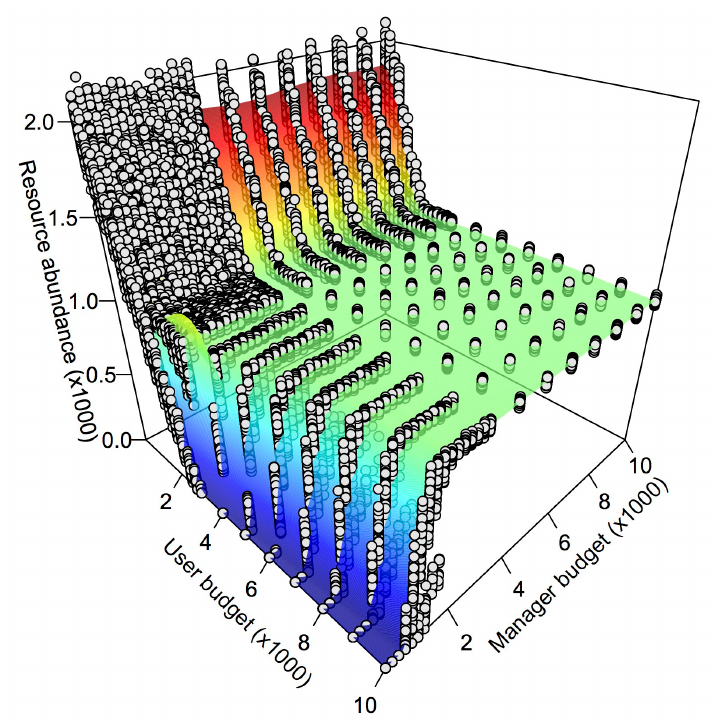
Fig. A1.1. Natural resource abundance observed as a function of user and manager budgets in the absence of conflict over management objectives. Dots denote resource abundance during the final management time step for each iteration of a user and manager budget combination. The fitted surface was obtained from a Poisson generalized additive model with a smooth tensor product representing the interaction between user and manager budgets. The surface colours are indicative of natural resource abundance (red = under-exploitation; green = target; blue = over-exploitation). The management target remained constant at 1000 individuals across the different combinations of user and manager budget. The natural resource population followed a logistic growth with an intrinsic growth rate of 0.2 and a carrying capacity of 2000